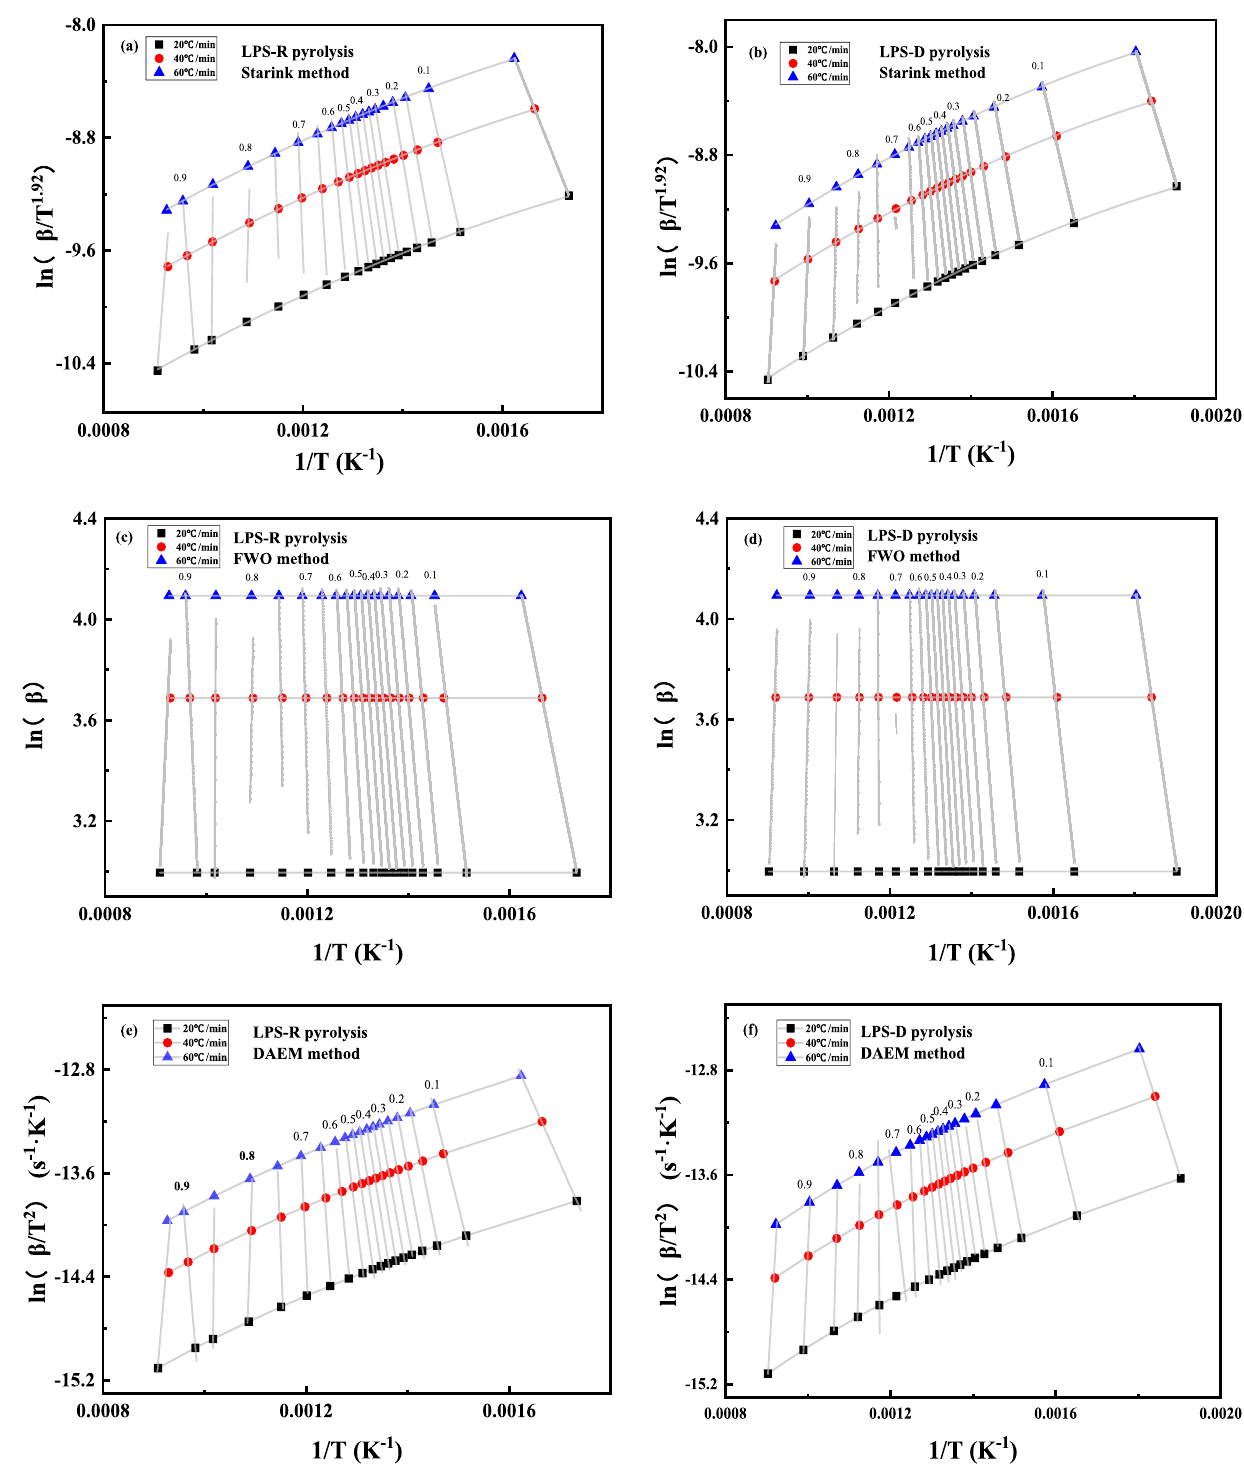
Fig. 7 Arrhenius plots of LPS-R and LPS-D with Starink, FWO and DAEM